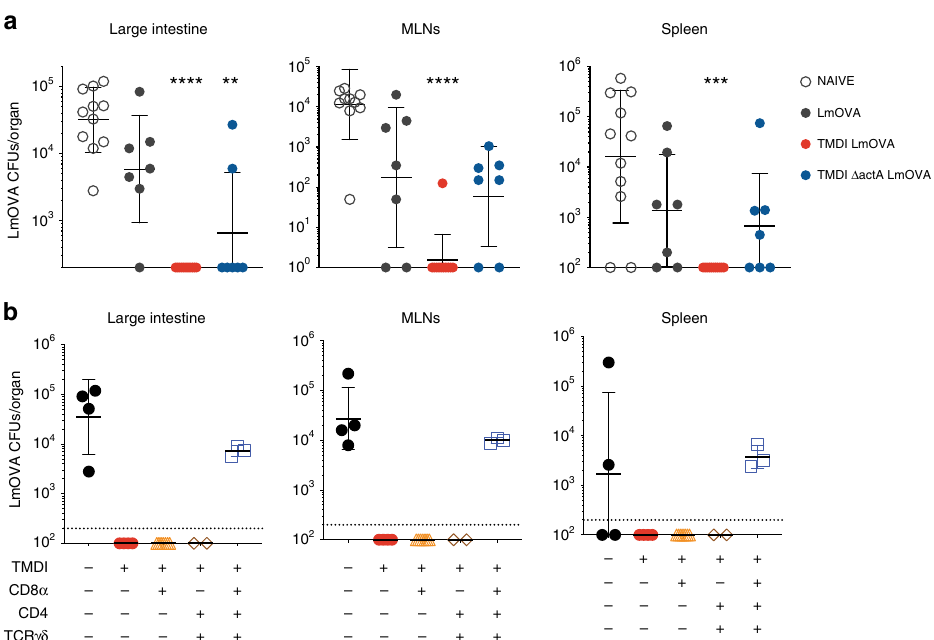
Fig. 6 TMDI provides enhanced protection and harnesses multiple T cell subsets. a C57Bl/6 mice were immunized with the depicted strategies and re- challenged orally with 2 × 10 10 LmOVA CFUs 30 days later. 3 days post re-challenge, mice were sacri fi ced and LmOVA CFUs in the indicated tissues were enumerated by plating ( n = 5 – 9 from 2 – 3 independent experiments; shown are geometric means ± geometric SD; Kruskal – Wallis test with multiple comparisons, *** p < 0.001, **** p < 0.0001). b C57Bl/6 mice were immunized via TMDI and re-challenged as described in a . At day − 3, − 1, and + 1 with respect to re-challenge, mice were injected with the depicted depleting antibodies targeting CD8 + , CD4 + or γδ T cells. CFUs were enumerated by plating at d3 post re-challenge ( n = 3 – 5 from 1 – 2 experiments per group; shown are geometric means ± geometric